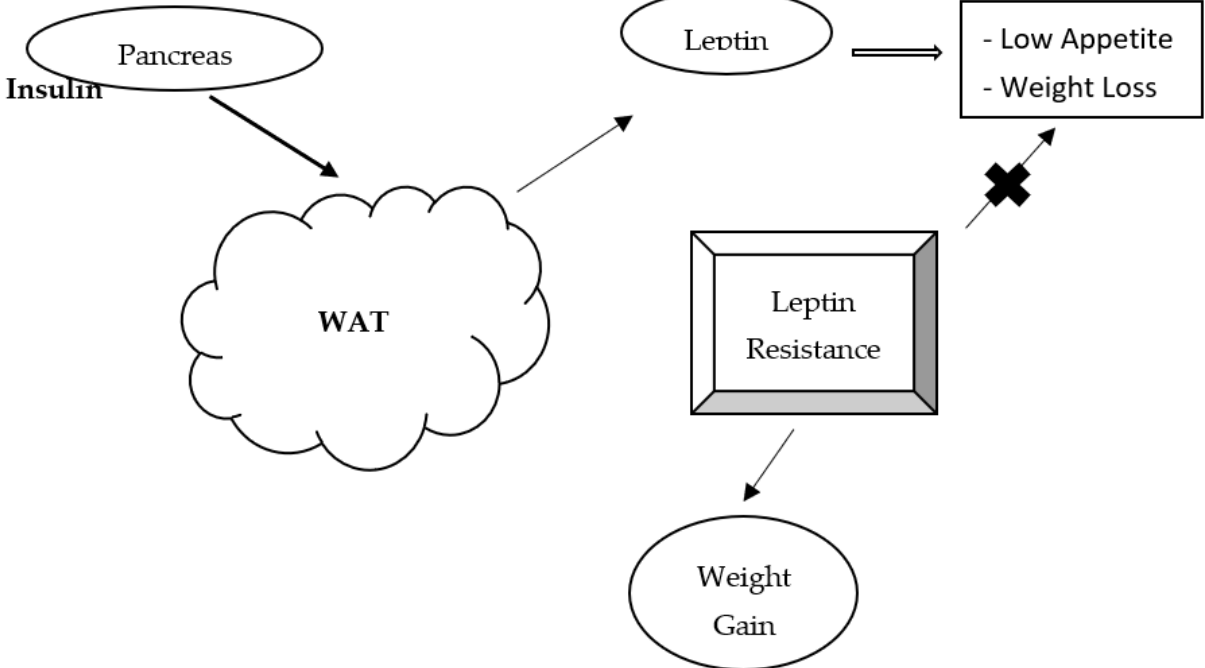
Figure 2. Insulin stimulates leptin synthesis and secretion from white adipose tissue. Increased serum leptin results in reduced appetite, food intake, and eventual weight loss. High serum leptin negatively impacts insulin secretion. In leptin-resistant patients, there is no suppression of appetite—eventually resulting in weight gain over time.